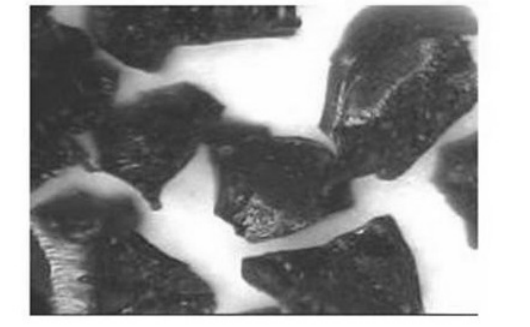
Figure 2. Optical photograph of AFM resin Table 2 . Thermodynamic parameters of AFM resin [E (kJ/mol) and